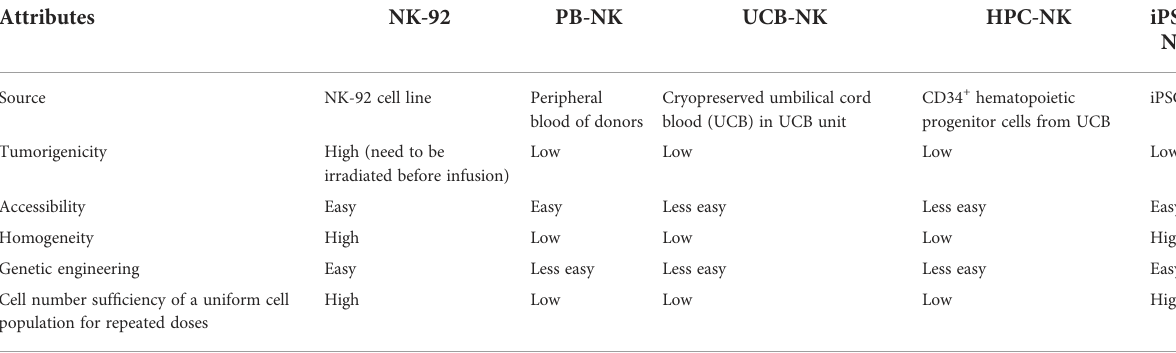
TABLE 3 Comparison of clinical-scale NK cells generated from distinct